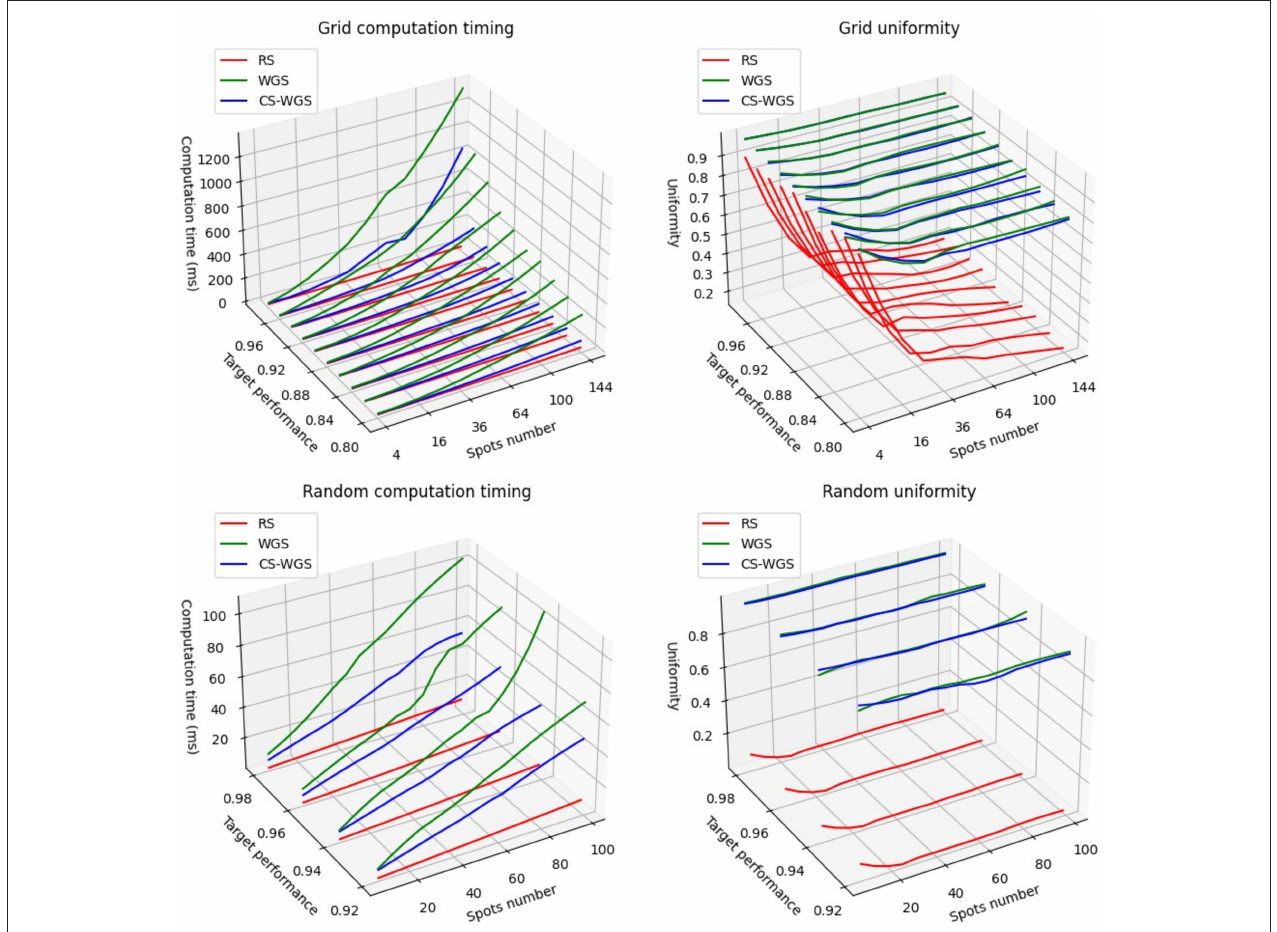
FIGURE 2 | Performance comparison of the algorithms when computing patterns at a set fraction of the full convergence